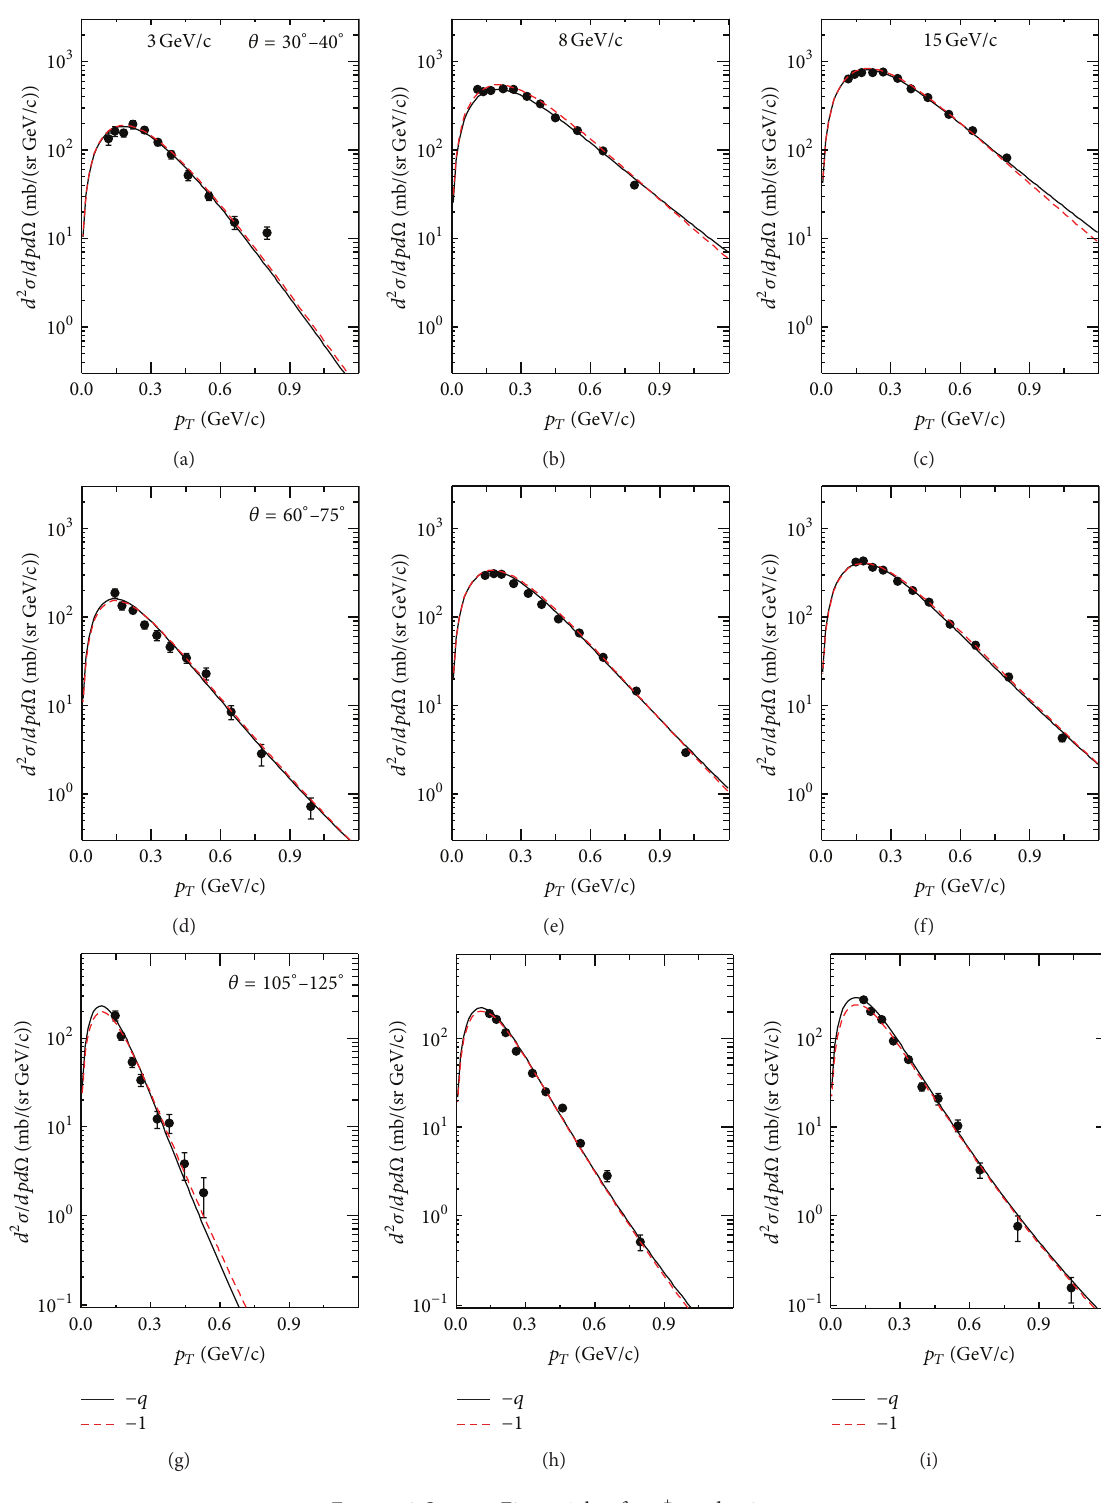
Figure 6: Same as Figure 4, but for 𝜋 +